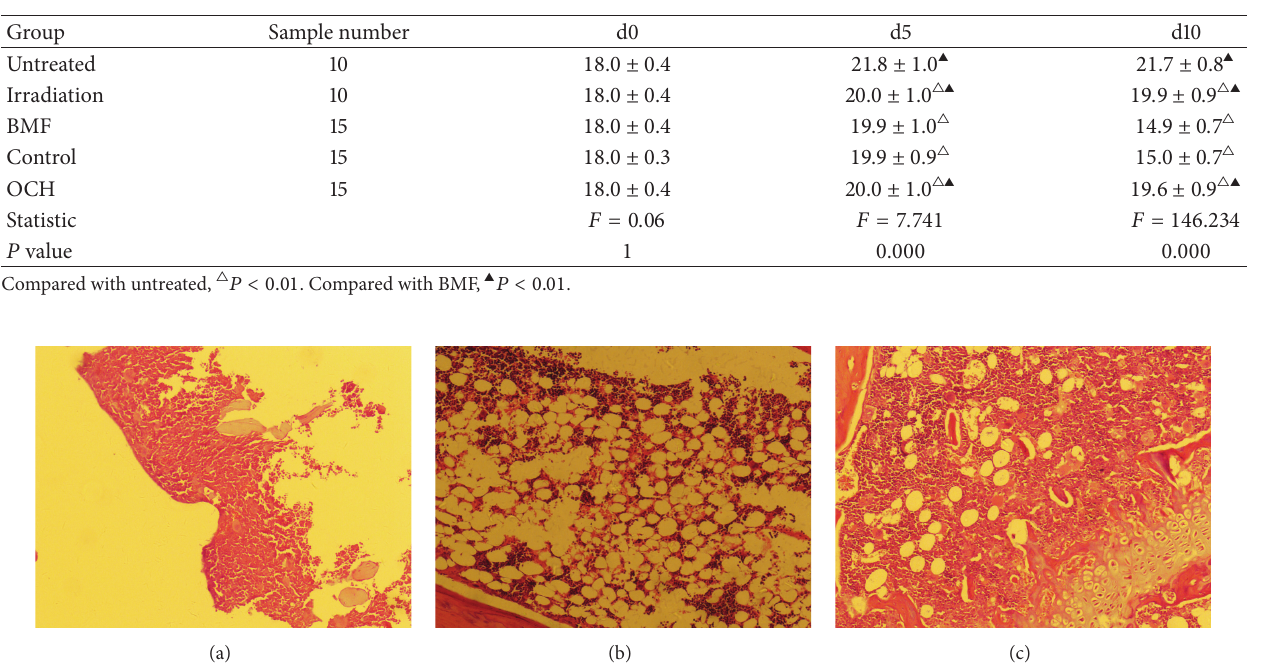
Table 2: Mice weight in different groups (g).